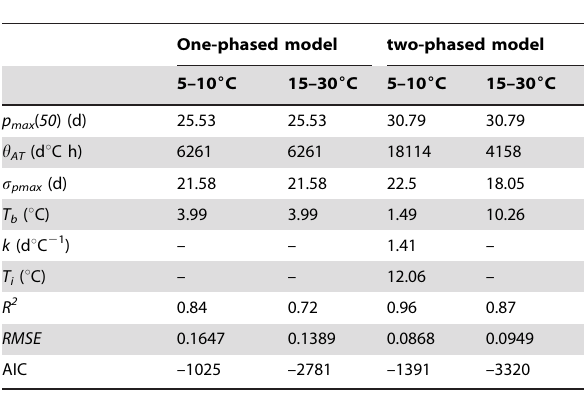
Table 3. Parameters of the aging thermal time (ATT) model describing the germination of aspen seeds across a range of temperatures and storage periods of